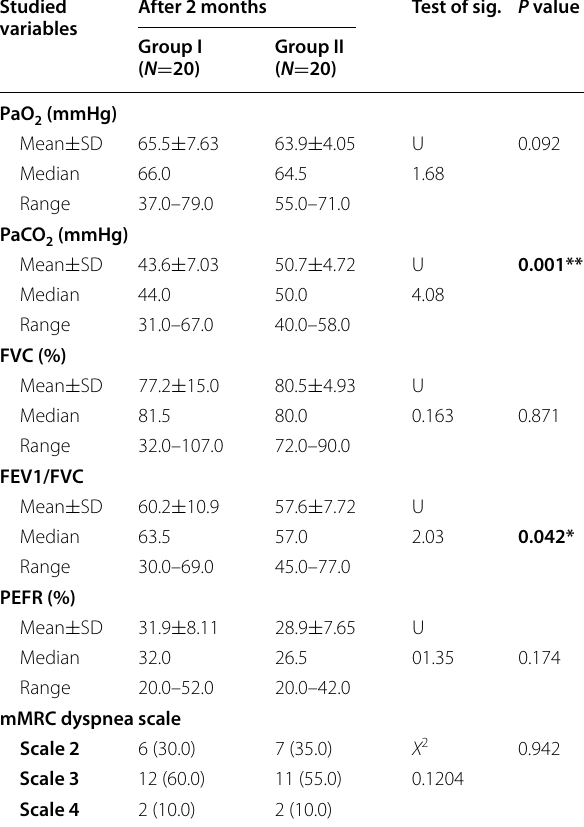
Table 5 Comparison between the studied groups regarding 40) diaphragm by ultrasound finding after 2 months ( N =